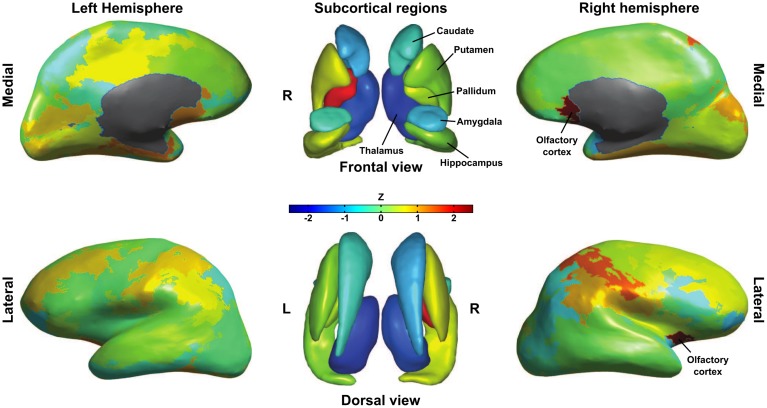
Differences in betweenness centrality between point estimates obtained from thresholded graphs and posterior distributions. For each subject we computed the distance between point and posterior estimates as their difference normalized to the posterior standard deviation. Subcortical and inflated cortical surfaces show the median of this distance over subjects. Note the consistent difference for right olfactory cortex, left pallidum and both thalami.